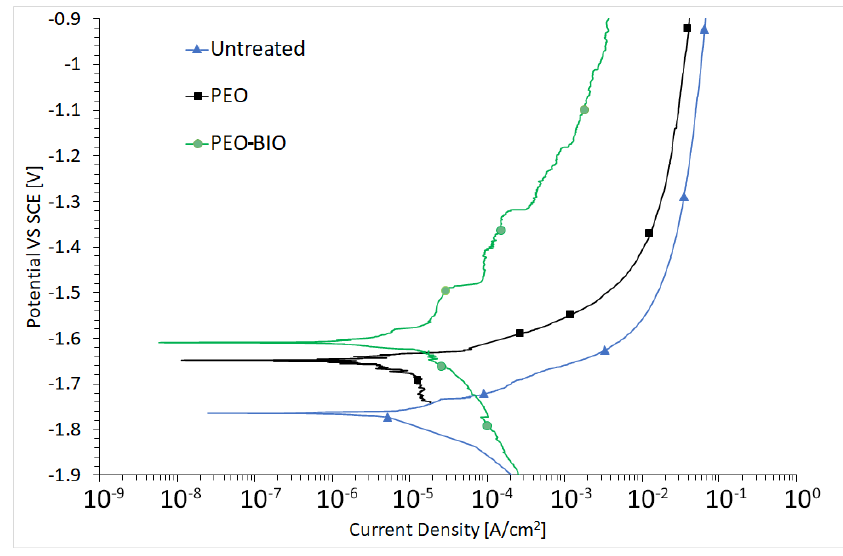
Figure 5. Potentiodynamic polarization plot of the different samples. Test electrolyte: simulated body fluid at 37 °C.